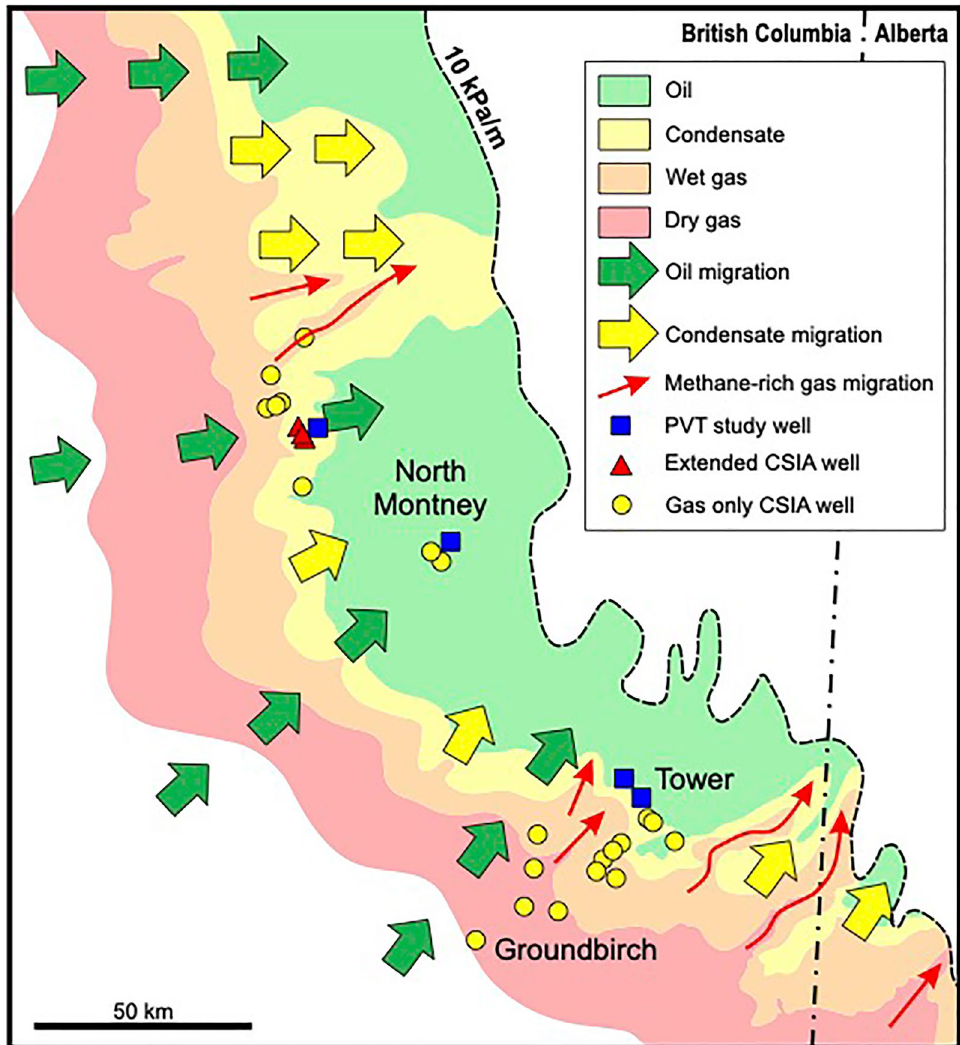
Figure 7. Map schematically showing multiple episodes of internal hydrocarbon migration in the unconventional Montney petroleum system of northeast British Columbia (BC) and northwest Alberta (AB). Colour shaded areas indicate present-day hydrocarbon fluid windows in the Upper Member of the Montney Formation. Green arrows show regionally widespread early migration of oil from distal Montney organic-rich source rocks 18–20 . Yellow arrows show regionally widespread migration of gas-condensate (this study). Red arrows show major pathways of late-stage methane-rich gas migration largely during basin uplift 15,17 . Dashed line indicates 10 kPa/m pressure-depth gradient contour, which marks the approximate updip edge of the over- pressured Montney unconventional petroleum system. Symbols show locations of wells with data used in this study area; PVT recombination PVT compositional data, CSIA compound-specific isotope analysis. Modified from Euzen et al. 12 . Used with permission of